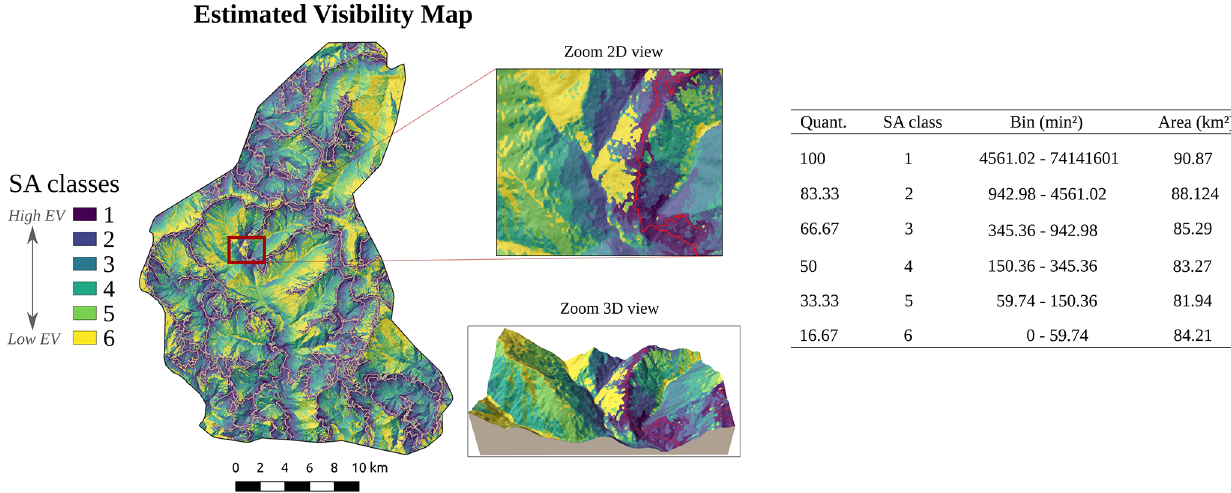
Figure 4. EV map for an object having a size of 78.54m 2 . Red lines in the zoom insets represent the roads used as reference observation points. The abbreviation Quant. refers to quantiles and min 2 stands for square minutes, a unit of measure of the solid angle.